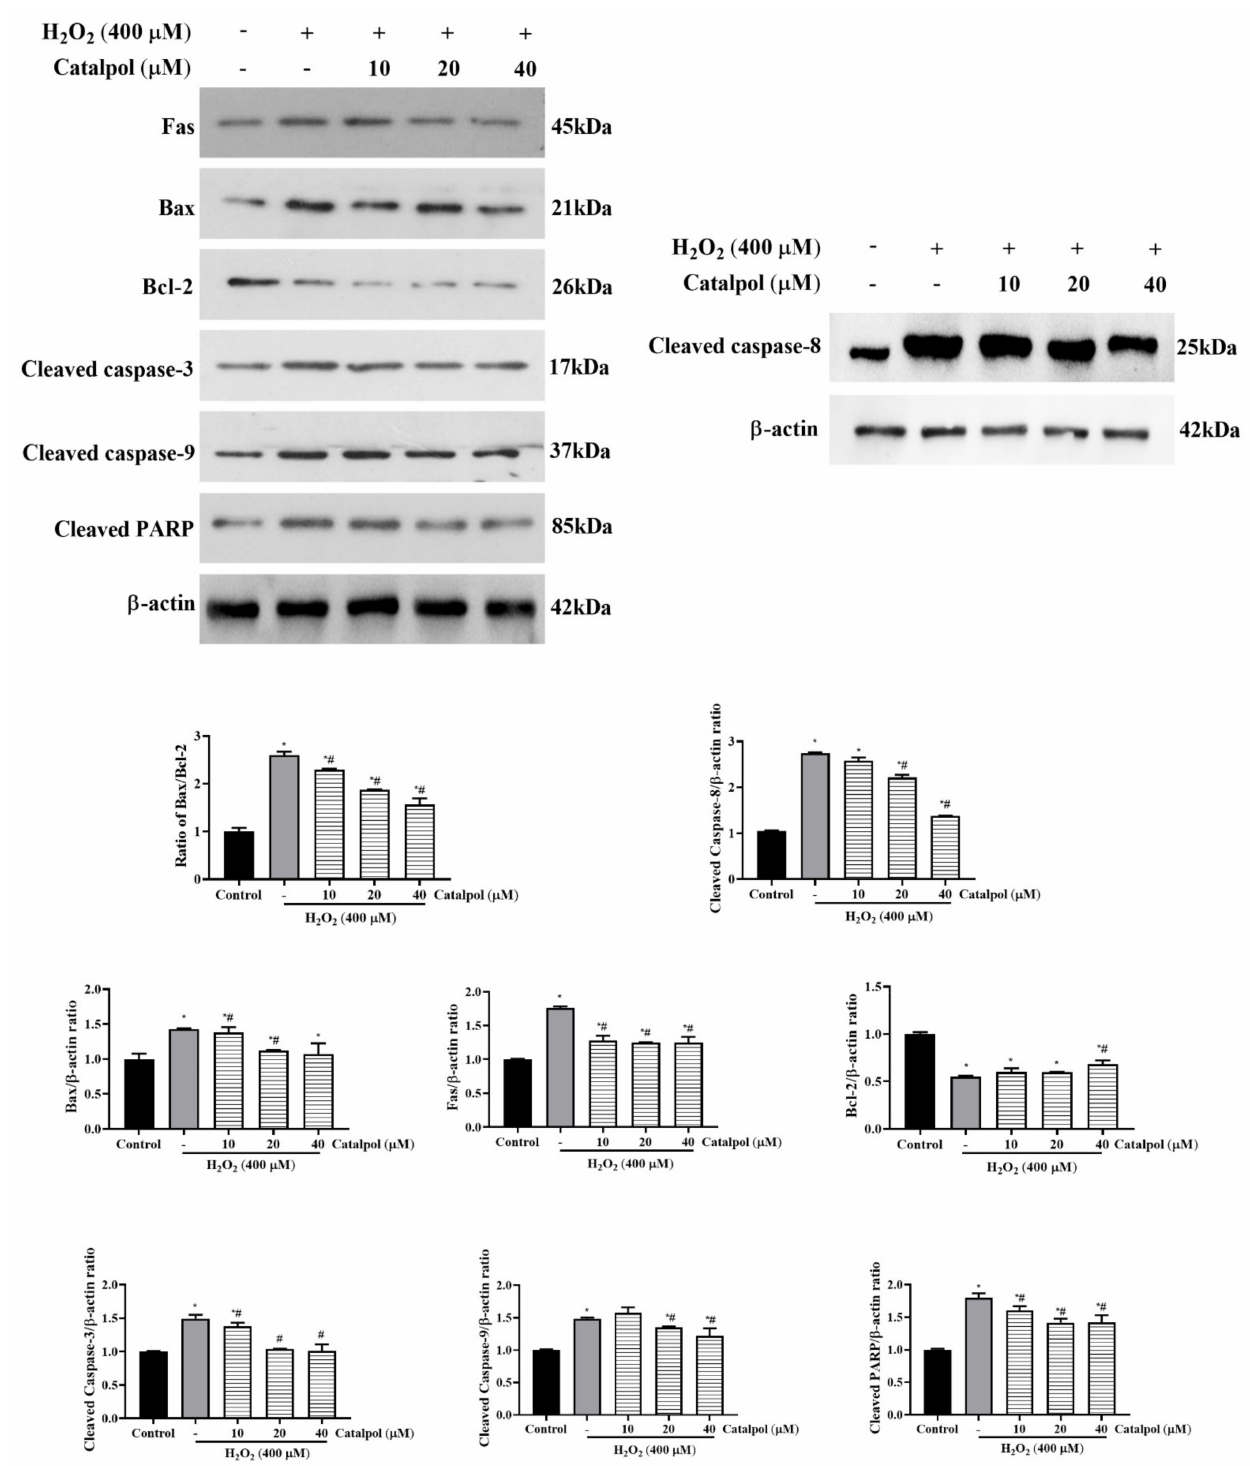
Figure 4. Regulation of apoptosis-related protein expression in H 2 O 2 -induced RPE cells by catalpol pretreatment. ARPE-19 cells were pretreated with or without catalpol (10, 20, and 40 µ M) for 24 h and then treated with 400 µ M H 2 O 2 for 6 h. The bands and relative protein expressions of Bcl-2, Bax, Fas, cleaved caspase-3, cleaved caspase-8, cleaved caspase-9, and cleaved caspase-PARP were measured with Western blot assay. β -actin was used as internal control. Data are presented as mean ± S.D. of three independent experiments (* p < 0.05 vs. control group, # p < 0.05 vs. H 2 O 2 (400 µ M)-treated